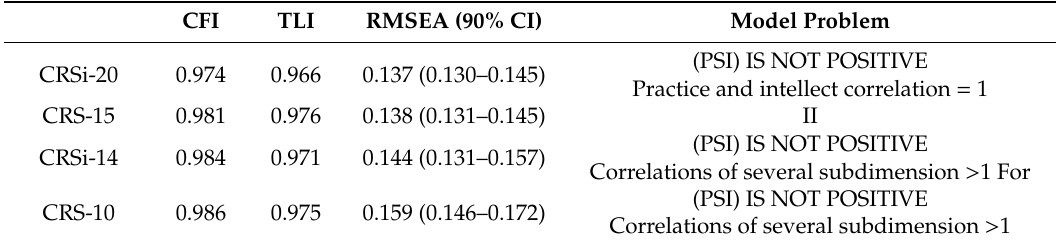
Table A2. CFA results of oblique models of CRS.